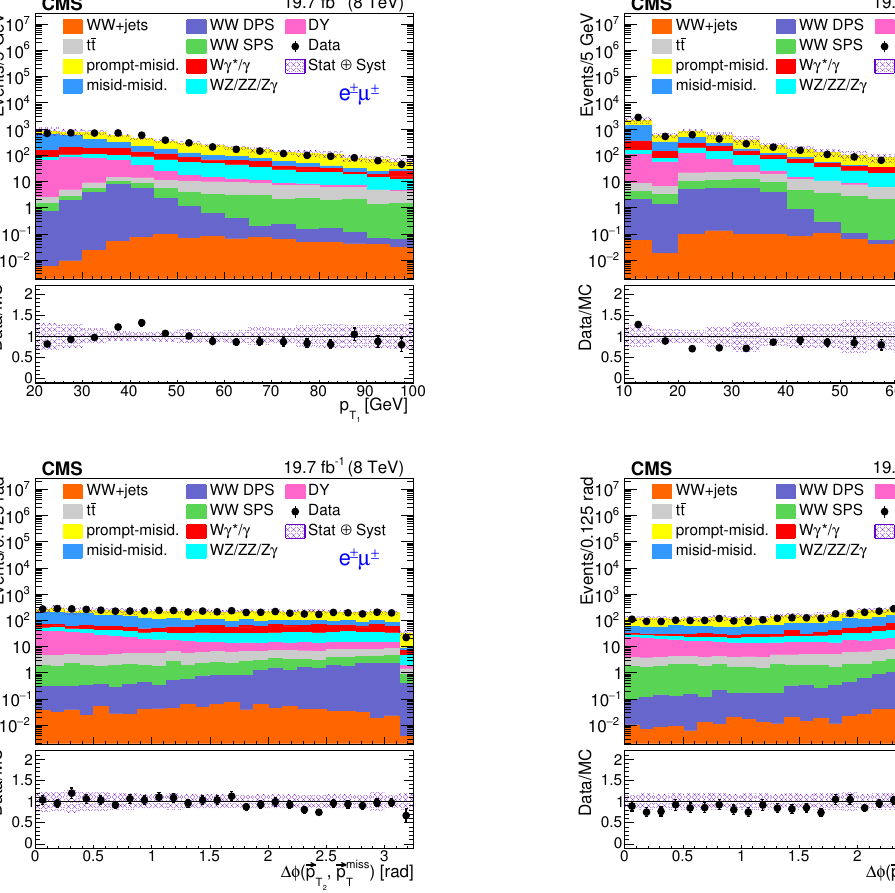
Figure 3 . Distributions of the p T (cid:1) (cid:30) ( ~p T ; ~p miss ) (bottom-right) variables for the electron-muon channel, after the same-sign WW T 12 selection criteria have been applied. Symbols and patterns are the same as in (cid:12)gure